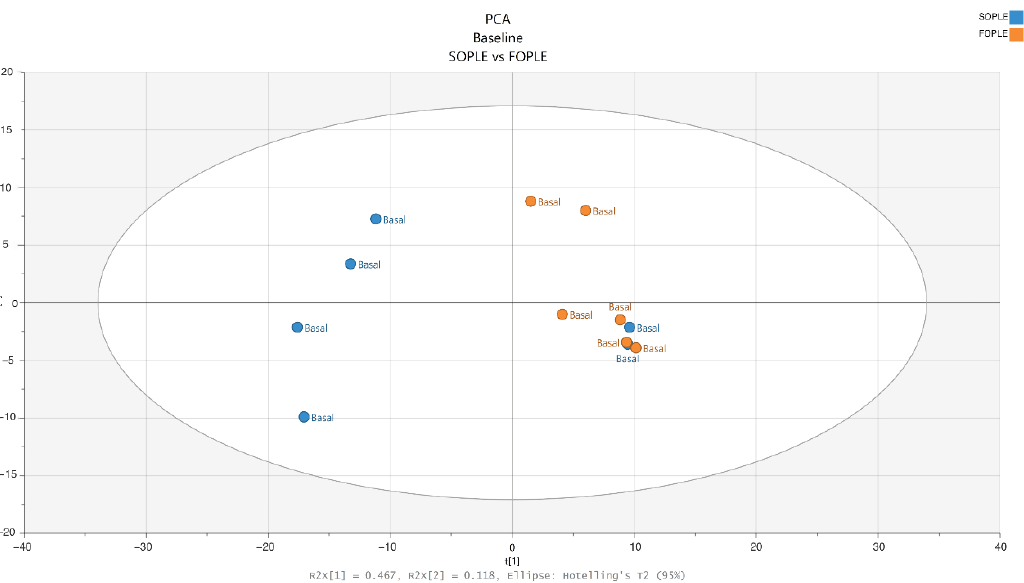
Figure 1. PCA scores plot of the model, including samples from SO-based parenteral lipid emulsion (SOPLE) and FO-based (FOPLE) parenteral lipid emulsion groups at baseline.